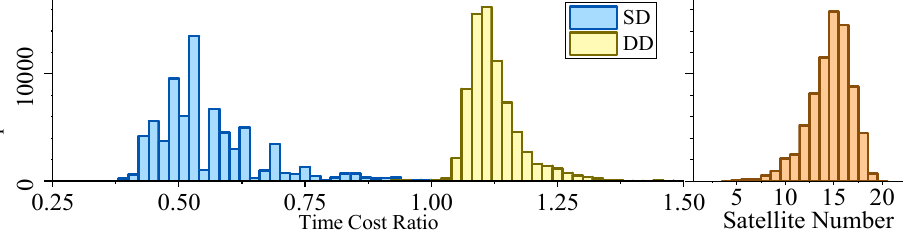
Figure 5. Time–cost ratio and satellite number histogram of dataset 1.